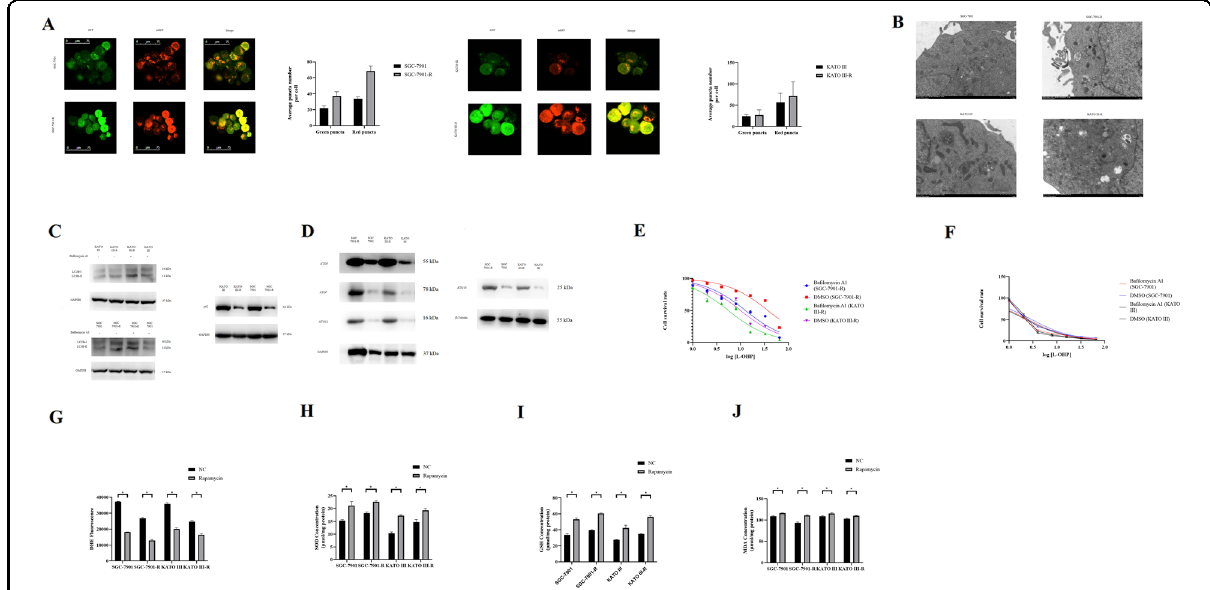
Fig. 5 Autophagy mediated oxaliplatin resistance of gastric cancer cells. A Autophagy fl ux is enhanced in SGC-7901-R compared with SGC- 7901; and KATO III-R compared with KATO III. The decreased green luciferase activity indicated enhanced autophagy fl ux: SGC-7901 vs SGC-7901-R, t = 3.893, P = 0.046; KATO III vs KATO III-R, t = 4.021, P = 0.039. B Electron microscope to observe autophagosomes in SGC-7901, SGC-7901-R, KATO III, and KATO III-R. C Expression of LC3B I/II and p62 in SGC-7901-R and KATO III-R compared with SGC-7901 and KATO III: LC3B I/II 16/14kDa, p62 62 kDa, GAPDH 37 kDa. D Expression of autophagy associated genes in SGC-7901-R and KATO III-R compared with SGC-7901 and KATO III: ATG5(ATG5-ATG12 complex) 55 kDa, ATG12(free ATG12) 16 kDa, ATG7 78 kDa, GAPDH 37 kDa, ATG10 25 kDa, β -Tubulin 55 kDa. E The in fl uence of Ba fi lomycin A1 on